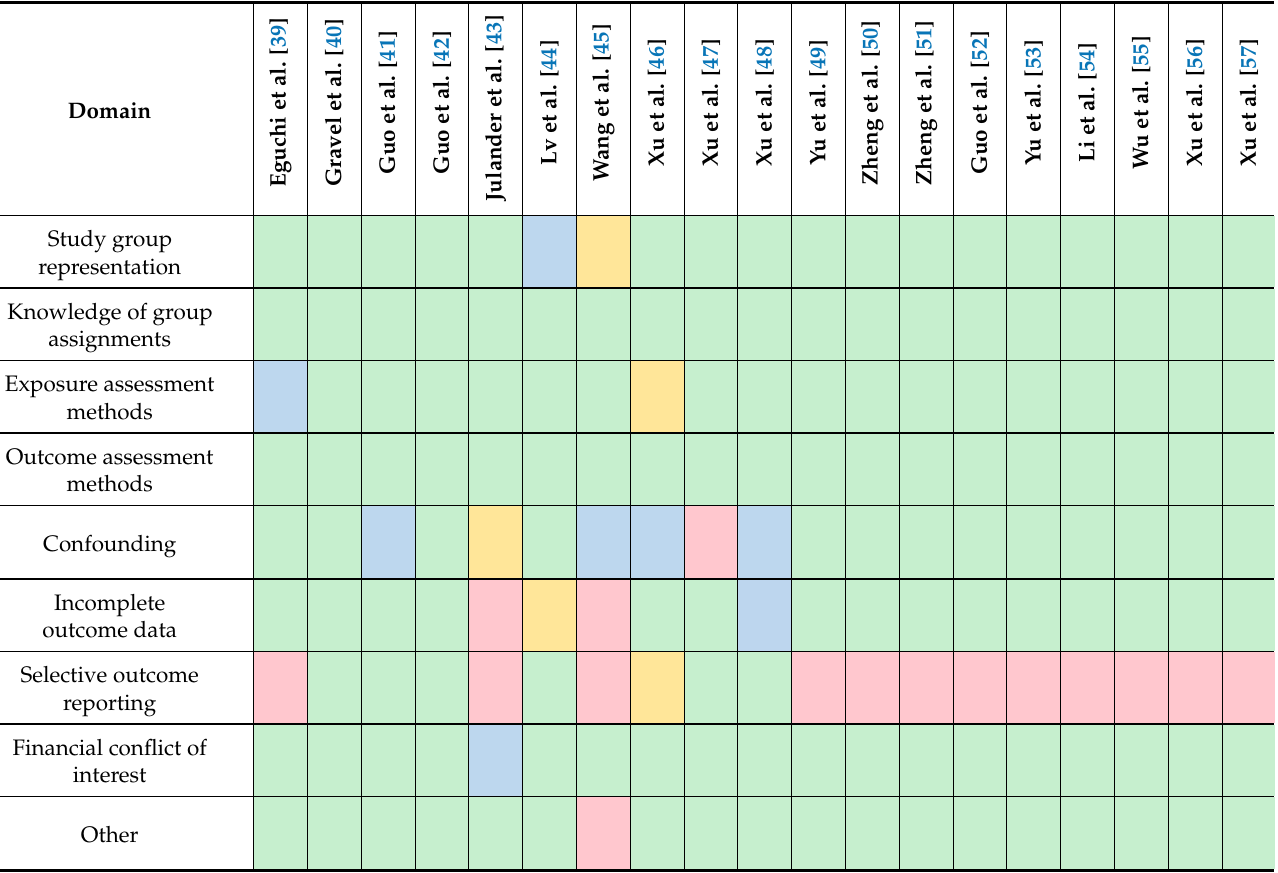
Table 3. Summary of risk of bias ratings assigned to the